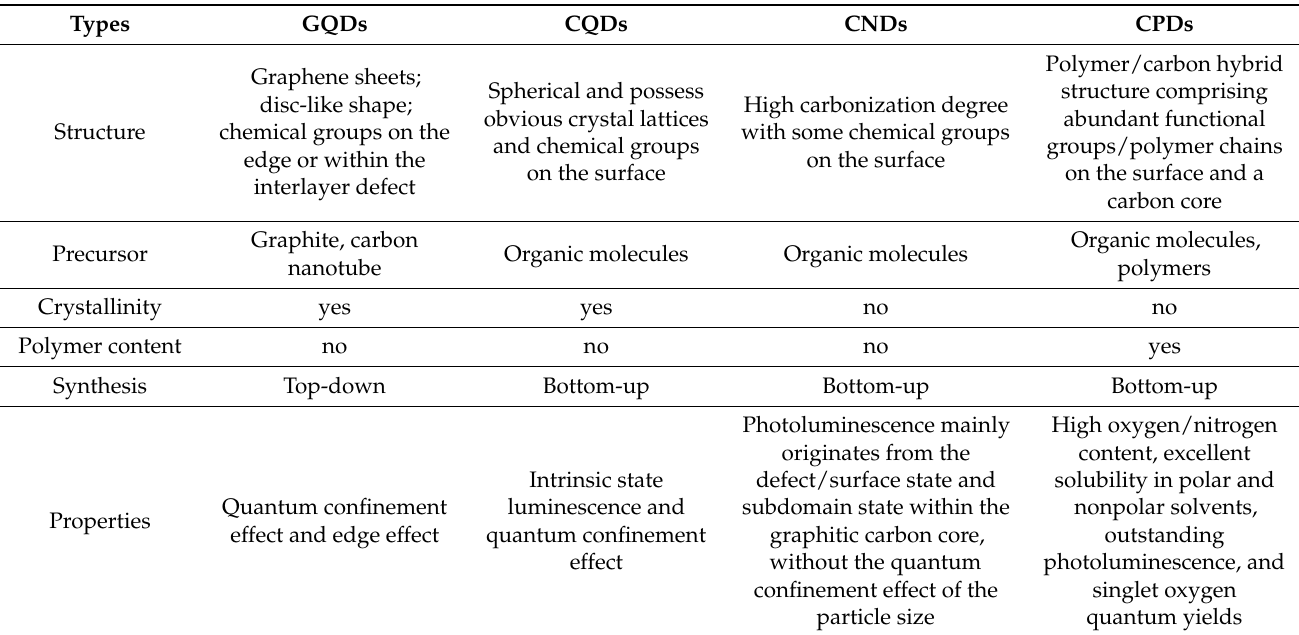
Figure 3. Types of carbon dots: GQDs, CQDs, CNDs, and CPDs. Table 1. Typical groups of